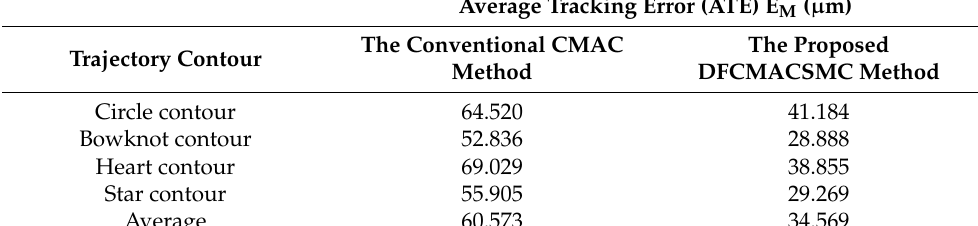
Figure 14. The path trajectory of the experiments. ( a ) The X − axis tracking response, ( b ) the Y − axis tracking response, ( c ) the star path response. Table 3. The experimental results showing contour tracking errors.